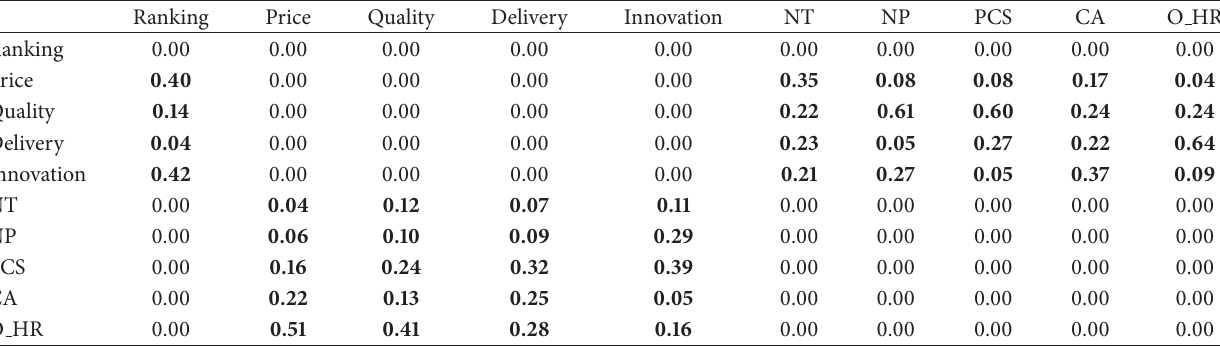
Table 6: Normalized supermatrix of decision agent